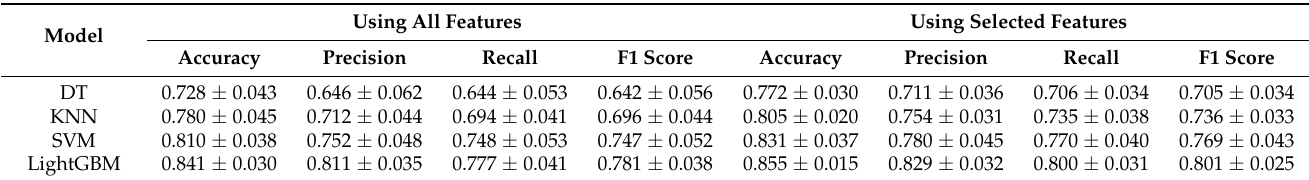
Table 6. Performance of the four machine learning models using different features.